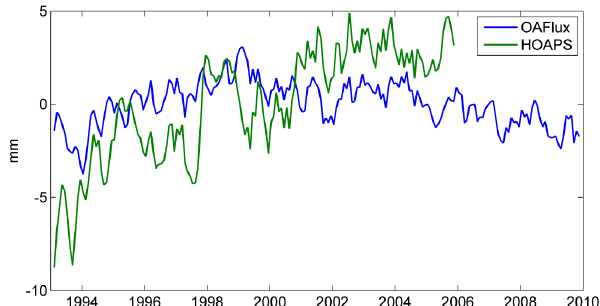
Fig. 6. Interannual variability of evaporation over ocean from Figure 6: Interannual variability of evaporation over ocean from OAFlux and HOAPS. 3 OAFlux and 4